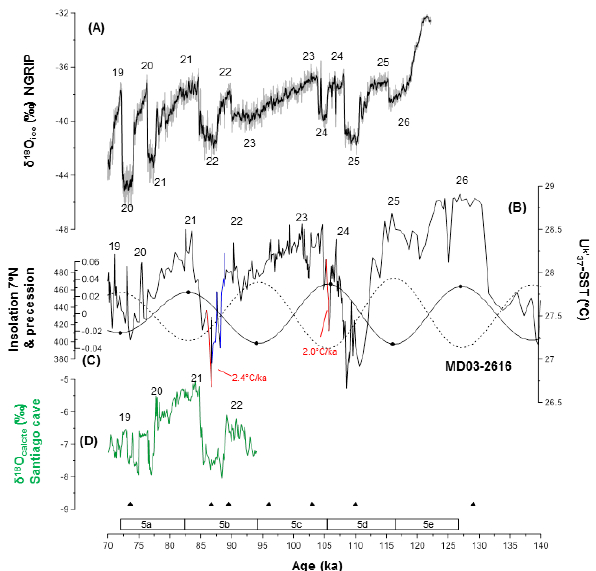
Figure 4. Abrupt changes over MIS5e-a. (a) δ 18 O ice (‰) mea- sured in NGRIP (NGRIP, 2004; Wolff et al., 2010). (b) MD03-2616 (cid:48) U k -SST (this study). (c) Precession (dashed line) and daily insola- 37 tion (solid line) at 7 ◦ N during the summer solstice (Berger, 1978). (d) δ 18 O Caclcite Santiago Cave (Mosblech et al., 2012). The blue and red lines represent abrupt cooling and warming SST changes, respectively (higher than 0.5 ◦ C and 2 ◦ Cka − 1 ). According to the Levitus database, the oxygen minimum zone in this area is located between 200 and 600m (Levitus,